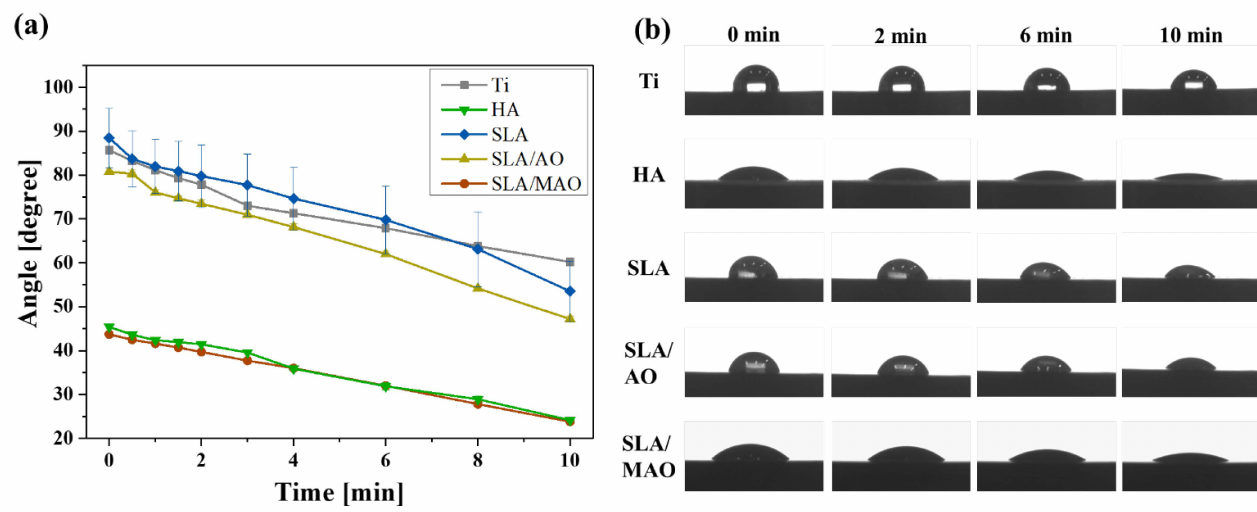
Figure 5. Measurement of wettability of surface-modified Ti through contact angle with water: ( a ) graph of the change in contact angle of each specimen over time and ( b ) monitored morphology of water drops on each specimen following dwelling